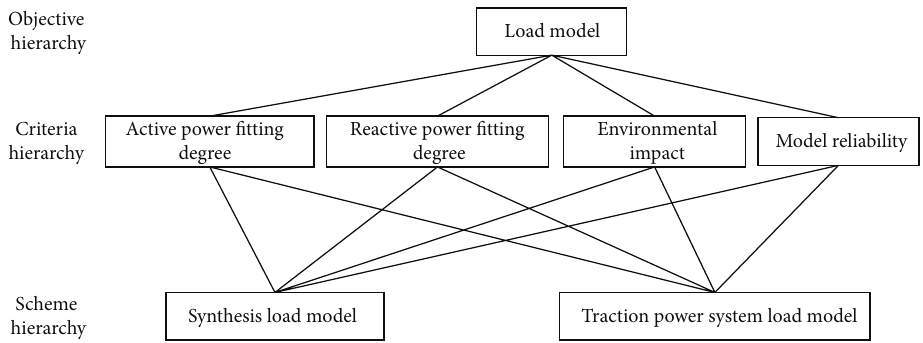
Figure 4: Hierarchy model structure of AHP.